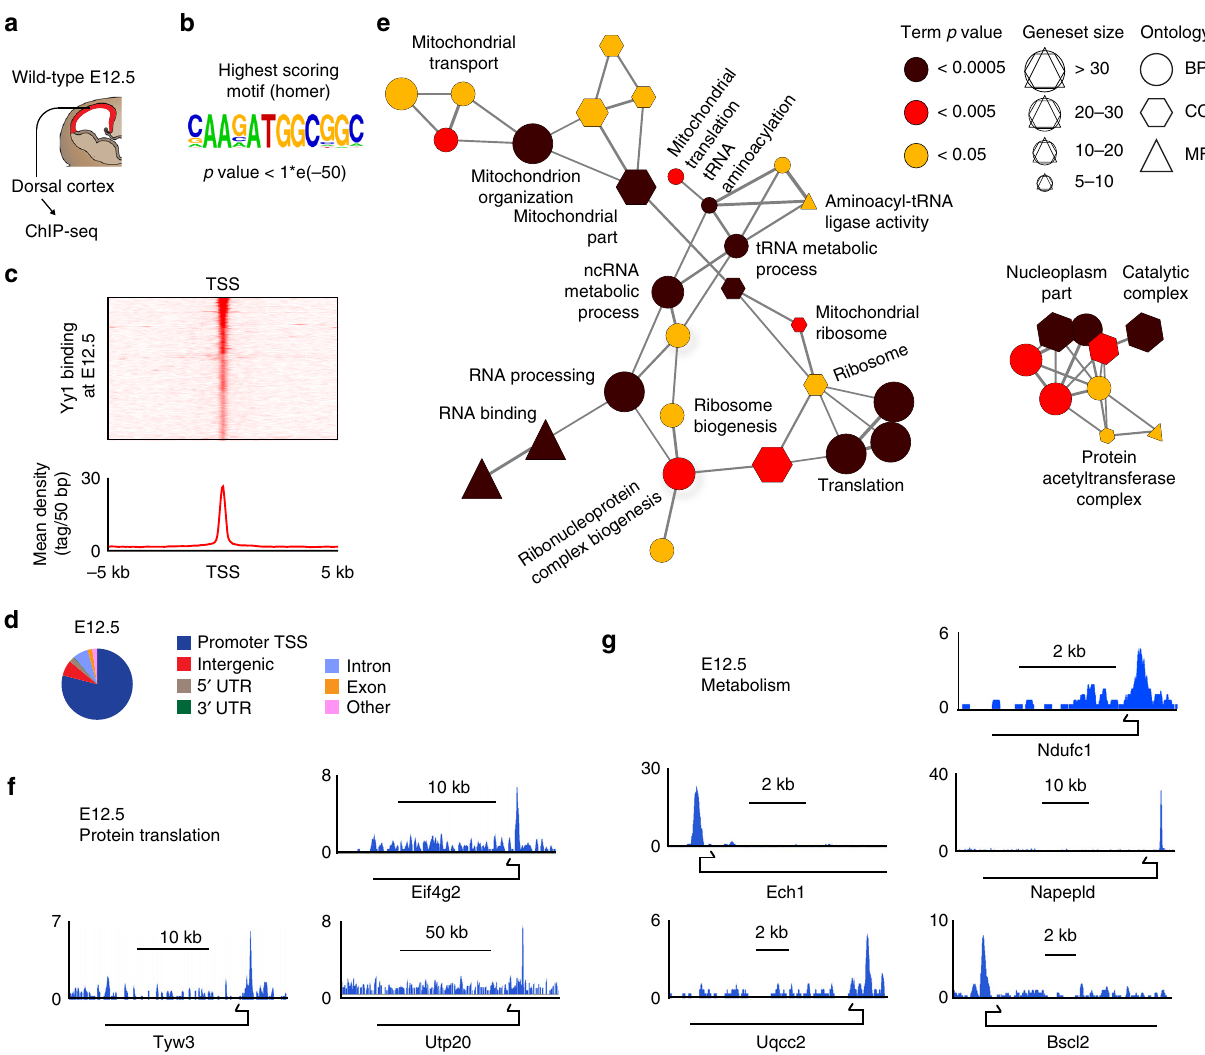
Fig. 5 Yy1 directly binds to metabolic genes. a Genome-wide binding of Yy1 to DNA regions was analyzed by chromatin immunoprecipitation against Yy1 followed by sequencing (ChIP-seq) of cortex cells derived at E12.5. Statistical analysis of the enriched regions identi fi ed 464 binding events at E12.5 (FDR < 0.001), present in at least 1 of 2 replicas. b Homer motif discovery revealed a known Yy1-binding motif as the highest scoring motif ( p < 1*e-50). c Read cluster pro fi le reveals preferential binding of Yy1 close to the transcription start site (TSS) of target genes. d Distribution of binding sites to different genomic locations. Yy1 binds preferentially to the promoter region of the transcription start site (TSS) of genes. e Gene Ontology (GO) term network analysis on the basis of Yy1-bound target genes at E12.5. Each node represents an enriched GO term (adjusted p value (Corrected with Bonferroni step down procedure) < 0.05). Nodes are interconnected when the gene overlap is > 50%, based on the kappa score. BP, biological process; MF, molecular function; CC, cellular component. A fully labeled version of the network is given in Supplementary Fig. 8. f , g Genomic snapshots depicting Yy1-binding events at metabolic genes ( g ) and genes involved in protein translation ( f ). kb, kilo